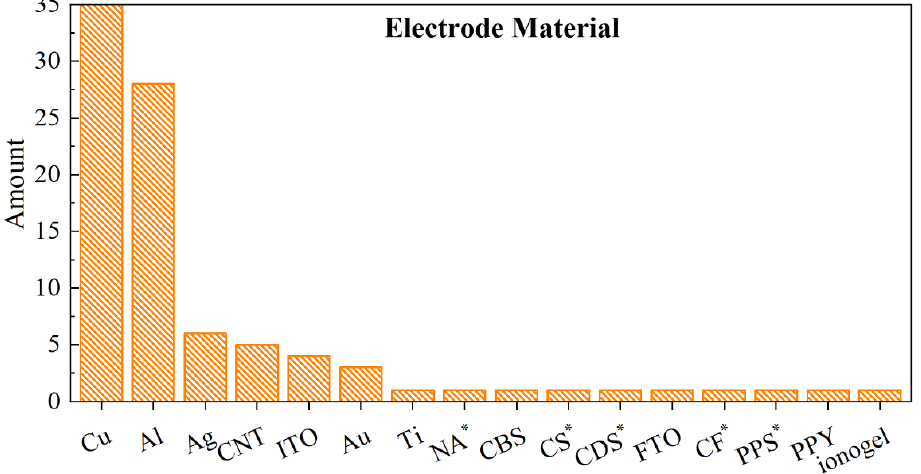
Figure 12. The statistics histogram of electrode materials. * represents the abbreviation: NA (Ni foam/Ag); CS (carbon sponge); CDS (conductive sponge); CF (conductive fabric); PPS (PEDOT:PPS).